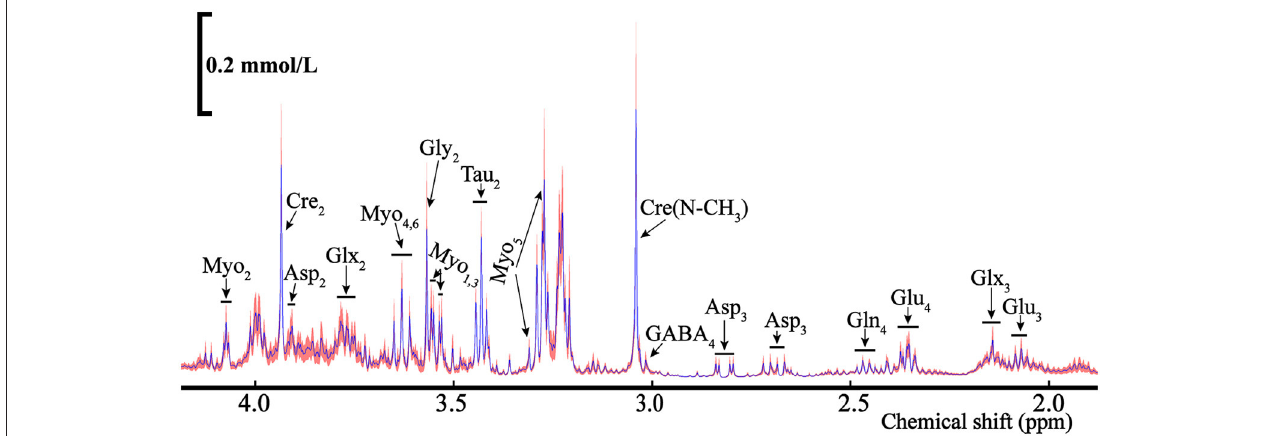
FIGURE 9 | The average NMR spectra for total metabolites ( 12 C + 13 C) from the POCE ( 1 H observed/ 13 C edited) for the rat’s ELGs. The blue line represents the average concentration of metabolites, with the red shaded part being the SEM.